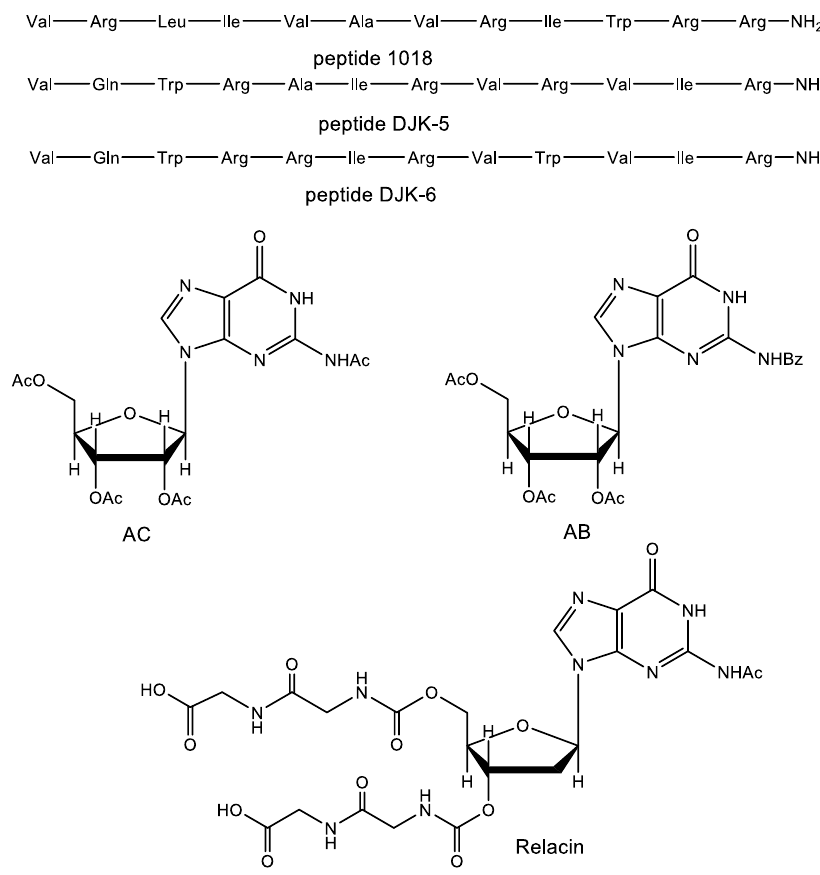
Figure 7. Inhibitors of the synthesis of the (p)ppGpp alarmone.